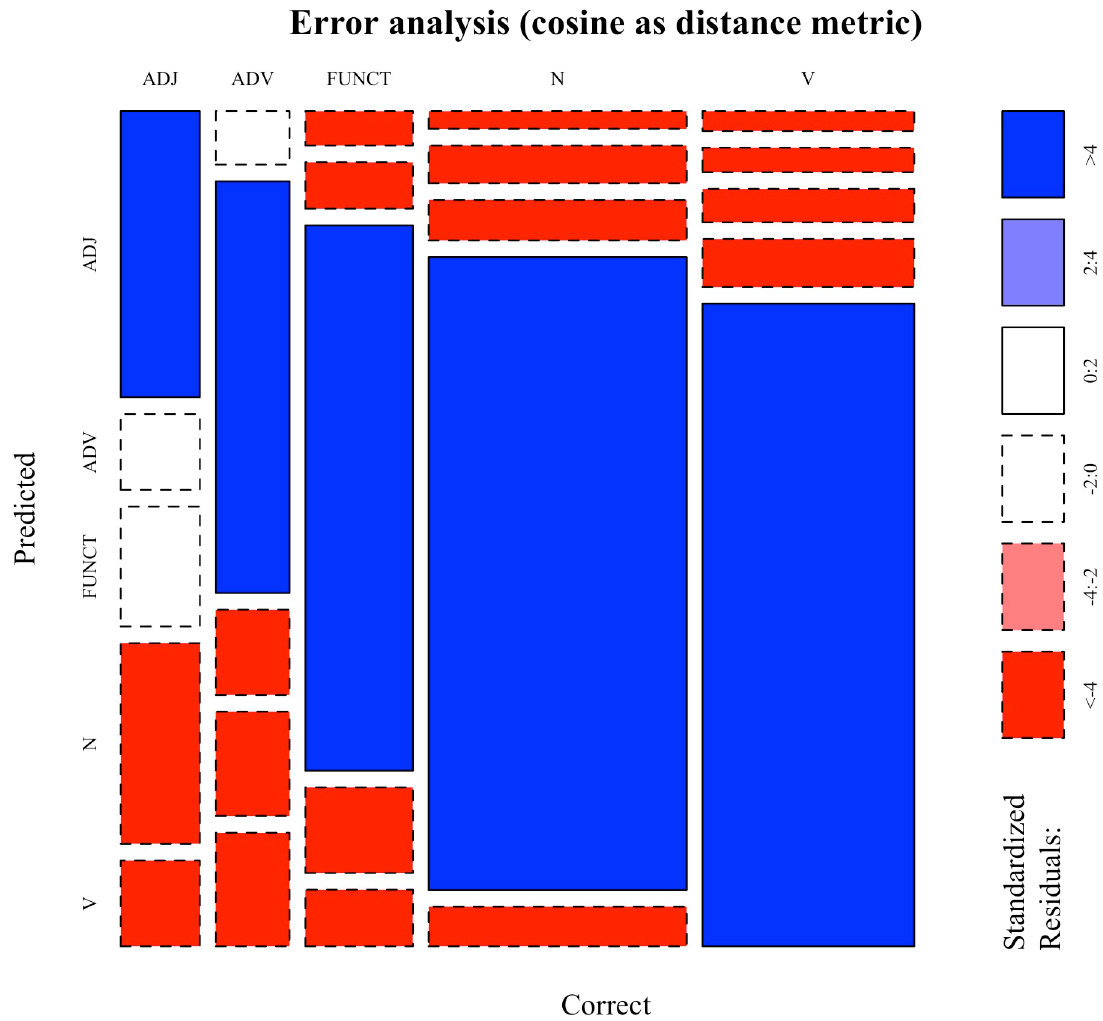
Fig 3. Cosine-based classification—Error analysis. Mosaic plot showing the error analysis of the categorization experiment performed using cosine as the distance metric to retrieve nearest neighbors. Blue cells indicate cases in which the observed frequencies significantly exceed the expected frequencies under the assumption of independence between Correct and Predicted PoS tags, while red mark the opposite scenario. ADJ: adjectives; ADV: adverbs; FUNCT: function words; N: nouns; V: verbs. For a detailed explanation of how to interpret the plot, refer to the main